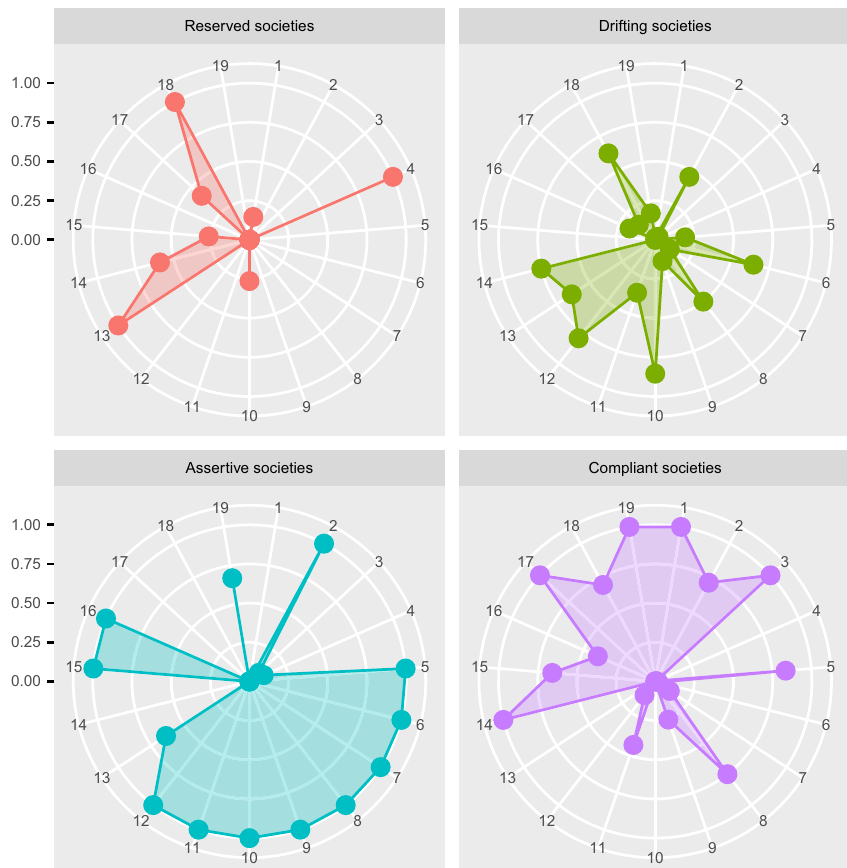
Fig. 1 Radial chart presenting rescaled median values of the variables by each cluster. Note : Numbers represent variables as follows: 1 = Doubling time, 2 = HAQ index, 3 = Population density, 4 = Population size, 5 = GDP per capita, 6 = Agency, 7 = Social networks, 8 = Preventative interventions, 9 = Civic and social participation, 10 = Freedom of assembly and association, 11 = Government effectiveness, 12 = Personal and family relationships, 13 = Travel and tourism direct contribution to GDP, 14 = Government Stringency Index, 15 = Doing something for the good of society, 16 = Behaving properly, 17 = Con fi dence in the government, 18 = Obeying rulers, 19 = Tests performed per million